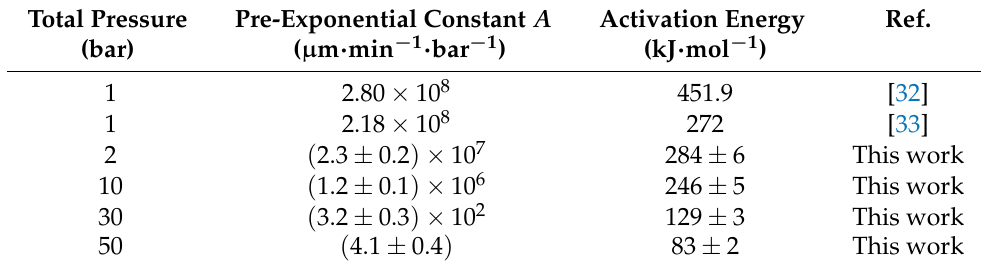
Figure 6. Pre-exponential factor—activation energy diagram for methane deposition at various pressures and following various authors. The dotted line is a guide for the eye to the data from this study. Table 3. Arrhenius law parameters obtained at different